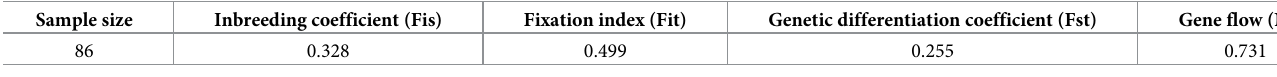
Table 5. Genetic differentiation among provenances of P . armeniaca var. ansu . Sample size